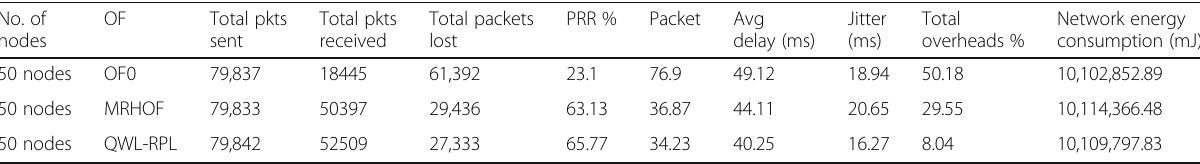
Table 8 Analysis of random topology with fixed heterogeneous traffic load No. of